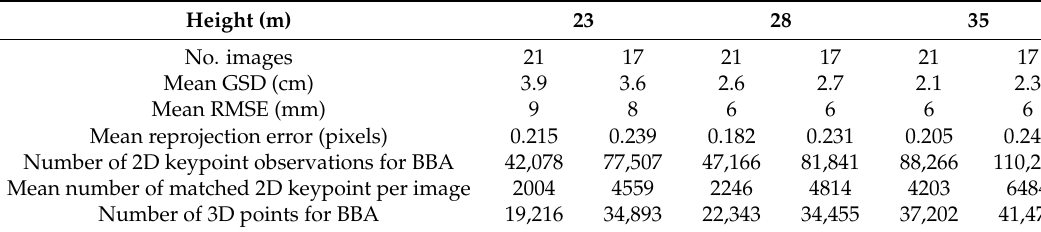
Table 3. Summary of full bundle adjustment (BBA) quality